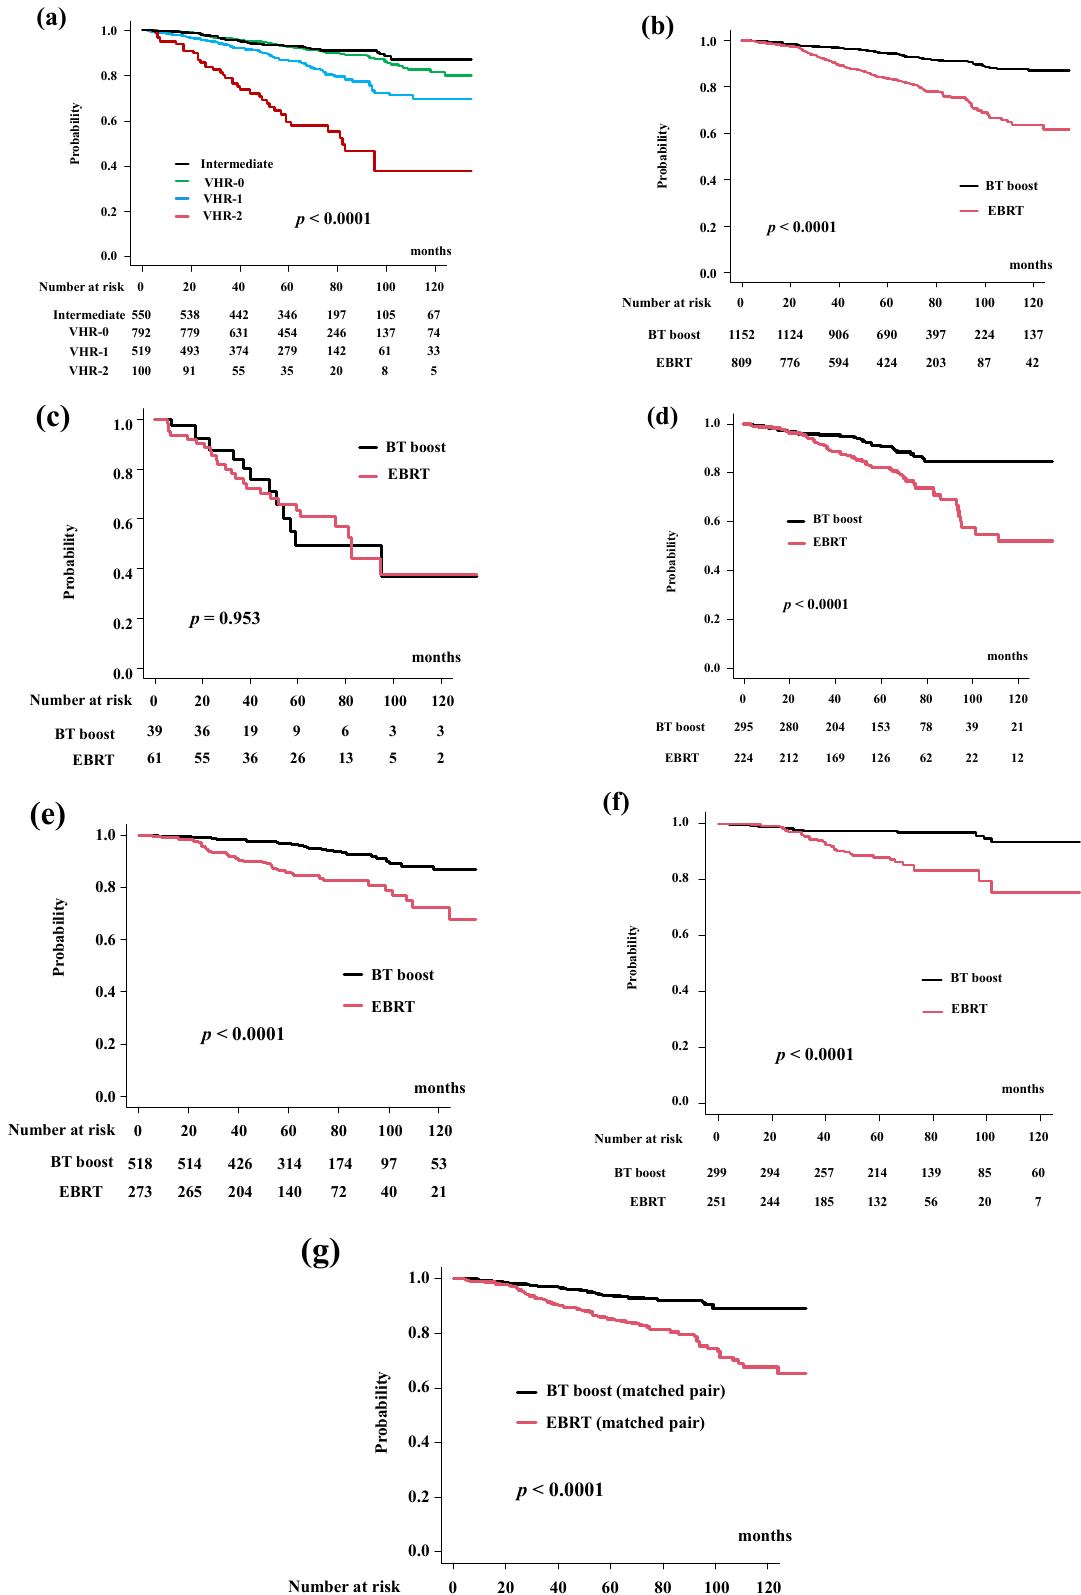
Figure 1. Biochemical control rates (biochemical disease-free survival rate; bDFS). ( a ) bDFS according to risk stratification. bDFS rates were 59.6% (95% CI: 47.5–69.7%), 86.8% (95% CI: 83.1–89.7%), 93.0% (95% CI: 90.8%–94.8%), 93.3% (95% CI: 90.7%–95.2%) at 5 years in the VHR-2, VHR-1, VHR- 0, and intermediate groups, respectively ( p < 0.0001). ( b ) Comparison of bDFS between EBRT and BT-boost. ( c ) Comparison of bDFS between EBRT and BT-boost in VHR-2 group. ( d ) Comparison of bDFS between EBRT and BT-boost in VHR-1 group. ( e ) Comparison of bDFS between EBRT and BT-boost in VHR-0 group, ( f ) Comparison of bDFS between EBRT and BT-boost in intermediate- risk group. ( g ) Comparison of bDFS between EBRT and BT-boost using matched pair analysis. BT-boost improved the bDFS to 94.2% (95% CI: 92.5–95.5%) at 5 years and 86.9% (95% CI: 83.4–89.8%) at 10 years compared to those in the EBRT group (83.7%, 95% CI: 80.7– 86.3% at 5 years and 63.7%, 95% CI: 56.8–69.7% at 10 years) (Figure 1b, p < 0.0001). The BT-boost group showed superior bDFS compared to that for EBRT in all groups, except for the VHR-2. The BT-boost group had bDFS rates of 49.1% (95% CI: 27.0–67.9%), 90.5% (95% CI: 85.8–93.8%), 96.9% (95% CI: 94.7–98.1%), 97.3% (95% CI: 94.6–98.6%) at 5 years in the VHR-2, VHR-1, VHR-0, and intermediate groups, respectively. The EBRT group had bDFS rates of 63.4% (95% CI: 48.8–74.8%, p = 0.953, Figure 1c), 82.2% (95% CI: 76.1–86.9%, p < 0.0001, Figure 1d), 85.8% (95% CI: 80.5–89.7%, p < 0.0001, Figure 1e), 87.9% (95% CI: 82.5–91.7%, p < 0.0001, Figure 1f) at 5-years in the VHR-2, VHR-1, VHR-0, and intermediate groups, respectively. We applied propensity score matching to generate well-matched pairs (649 and 649 patients; background comparisons are shown in Supplemental Table S1b). The actuarial